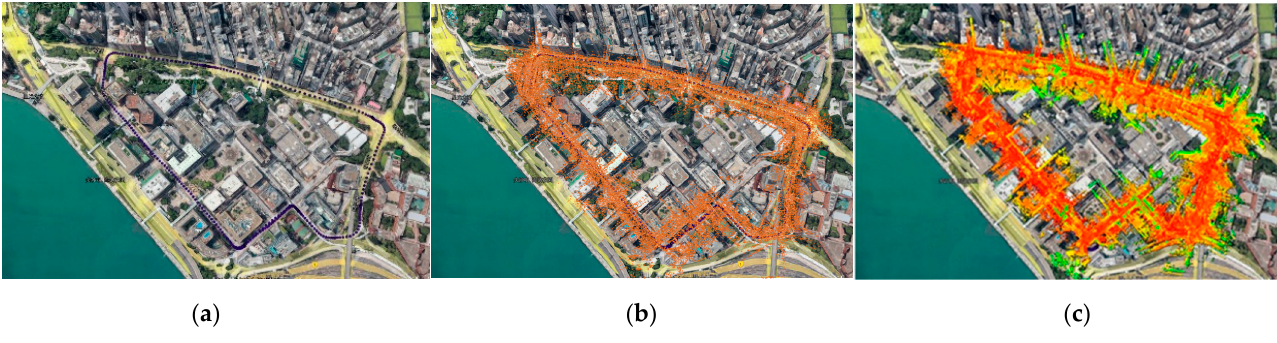
Figure 15. Comparison of mapping effects of various algorithms. ( a ) The ground truth. ( b ) The mapping results of LIO-SAM. ( c ) The mapping results of the proposed algorithm.